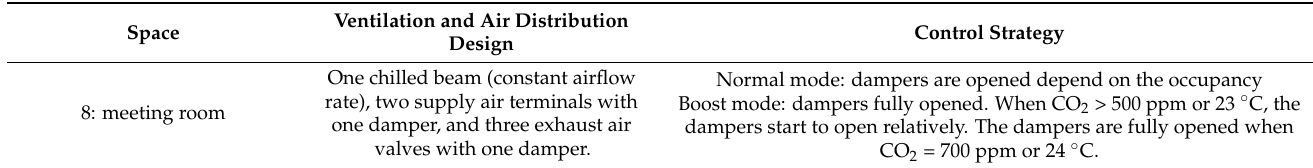
Table 6. Ventilation and air distribution design and control strategies for Type 4